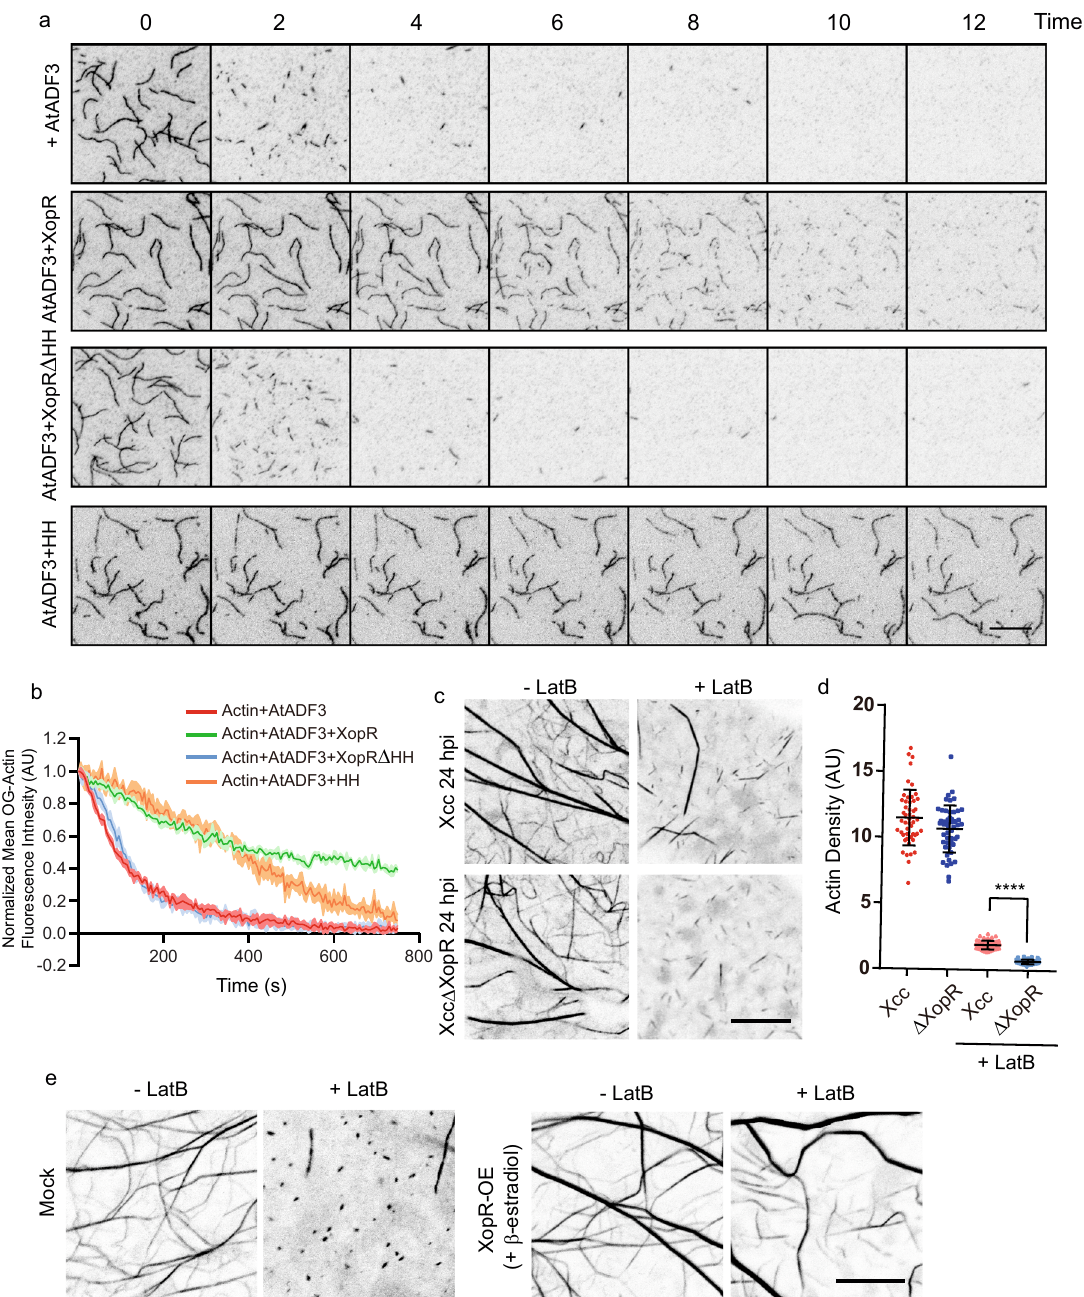
Fig. 6 XopR inhibits ADF-mediated actin depolymerization through direct competition. a Representative time-lapse TIRF images of F-actin depolymerization. To obtain these images, 100 nM XopR, 100 nM XopR Δ CC, 0.2 μ M AtADF3, and 20 μ M CC peptide were used. b Mean fl uorescence intensity of F-actin of a ( n = 6, data were presented as mean values with error bands which represent SD). c Representative images of Lifeact-Venus in epidermal cells of WT Arabidopsis cotyledons. Seven-day-old seedlings were fl ood-inoculated with Xcc or Xcc Δ xopR , and then treated with 1 μ M actin LatB for 1 h after 24 hpi. Scale bar = 10 μ m. d F-actin density quanti fi cation in c ( n = 50 images from fi ve individual seedlings (Data were presented as mean values ± SD). e Representative images of Lifeact-Venus in epidermal cells of Arabidopsis cotyledons expressing XVE-XopR. The expression of XopR was fi rst induced for 24 h using 10 μ M β − estradiol before being subjected to 1 μ M LatB treatment for 1 h before imaging. Scale bar = 5 μ m for a , Scale bar = 10 μ m for c , e . Two-tailed Student ’ s t -test was performed assuming equal variance. Ns no signi fi cant difference, * p < 0.05, ** p < 0.01, *** p < 0.001, **** p <